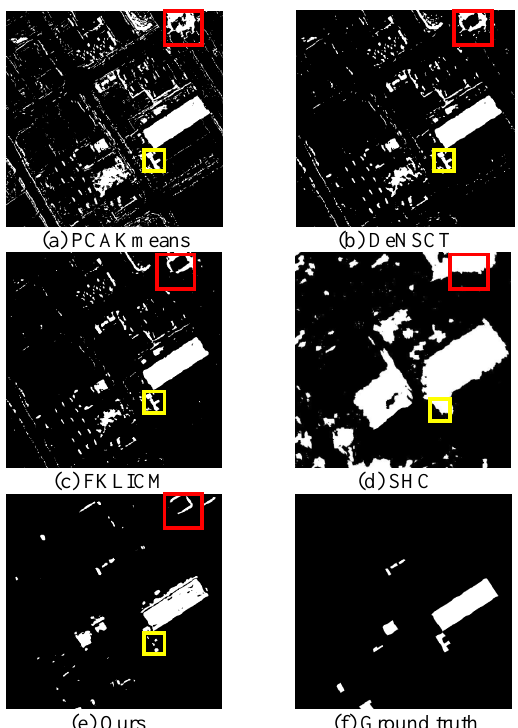
Figure 4. Results of other method and ours and the ground